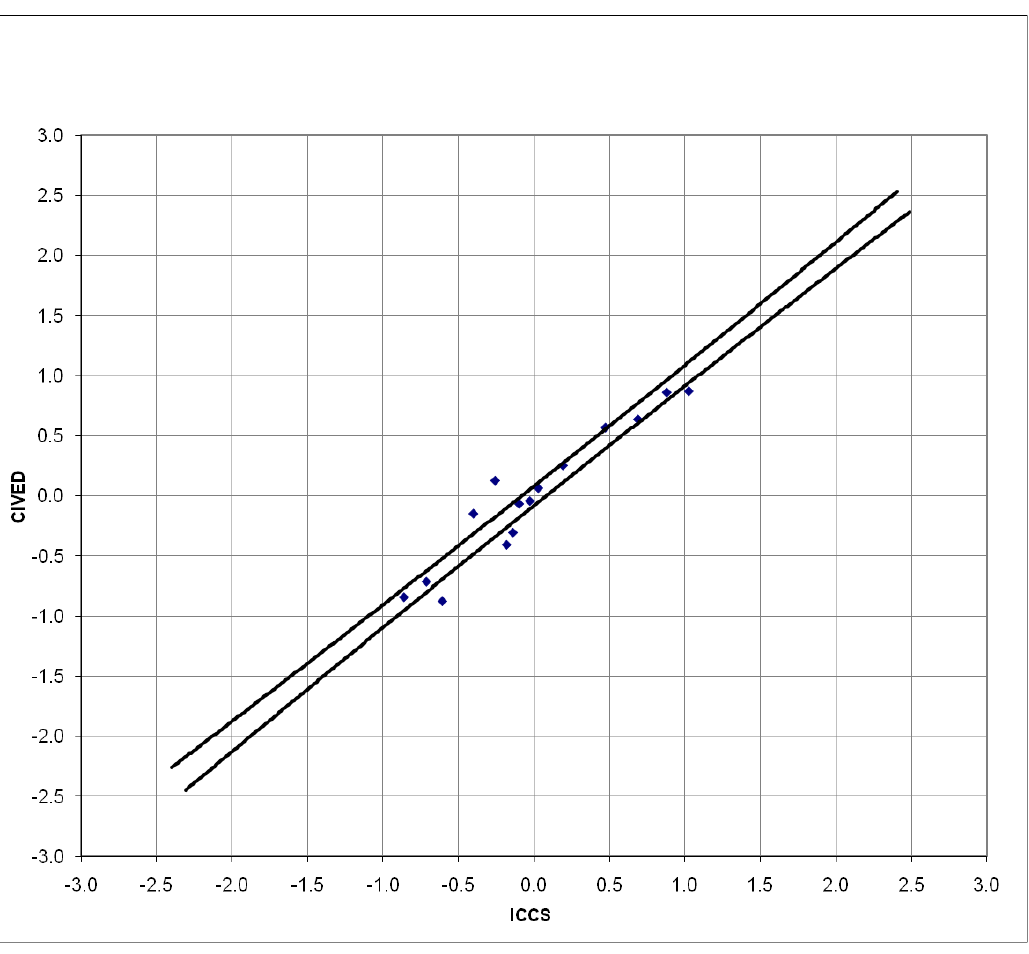
Figure 1: Scatter plot for link item parameter